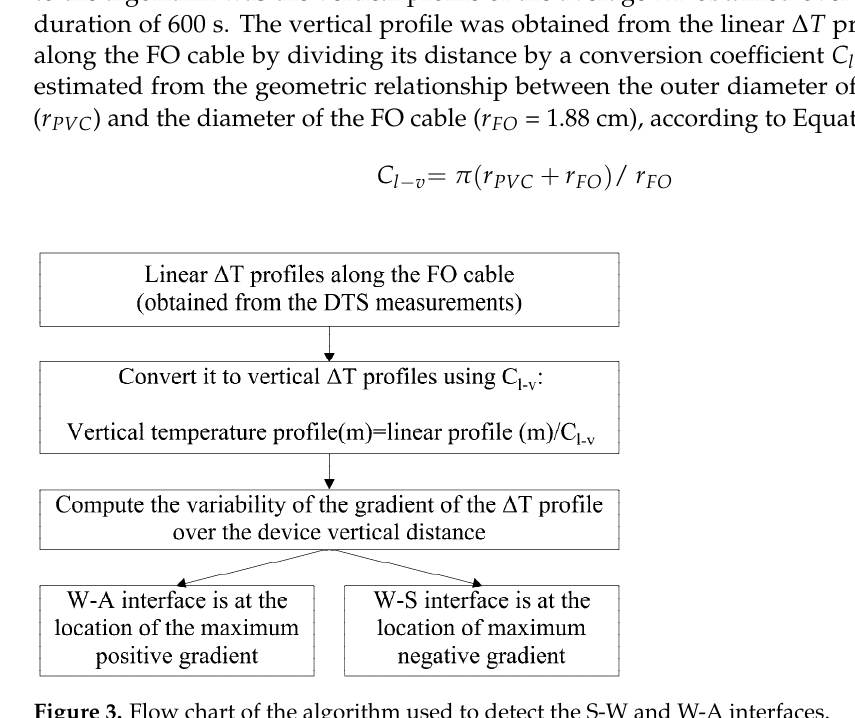
Figure 3. Flow chart of the algorithm used to detect the S-W and W-A